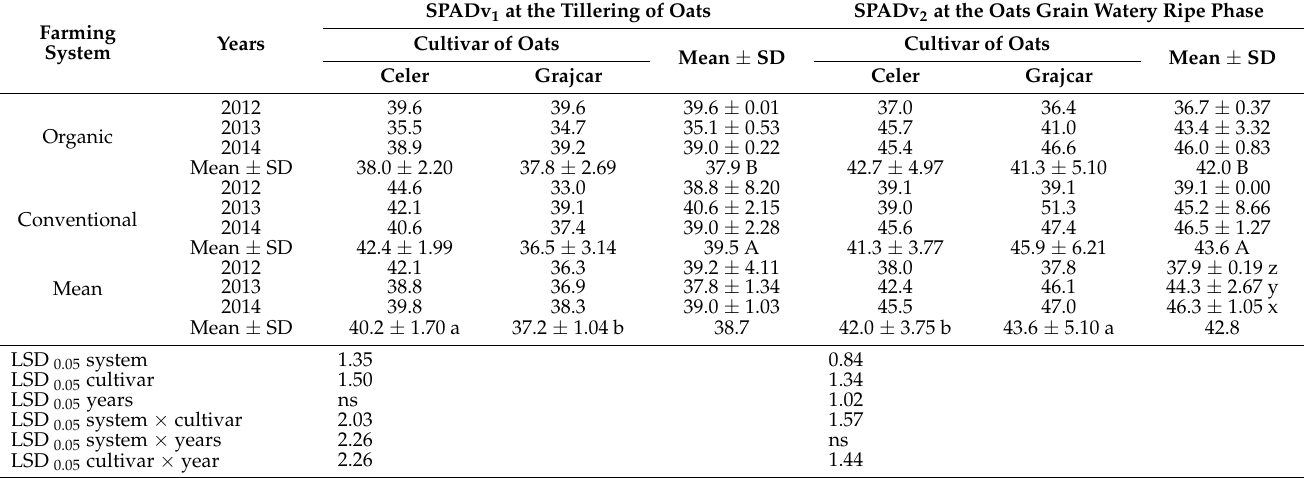
Table 3. The leaf chlorophyll content (relative content of chlorophyll) of vetch in the mixtures with oats measured at oats tillering (SPADv 1 ) and oats grain watery ripe phase (SPADv 2 ), depending on the farming system and oats cultivar in 2012–2014. Farming System